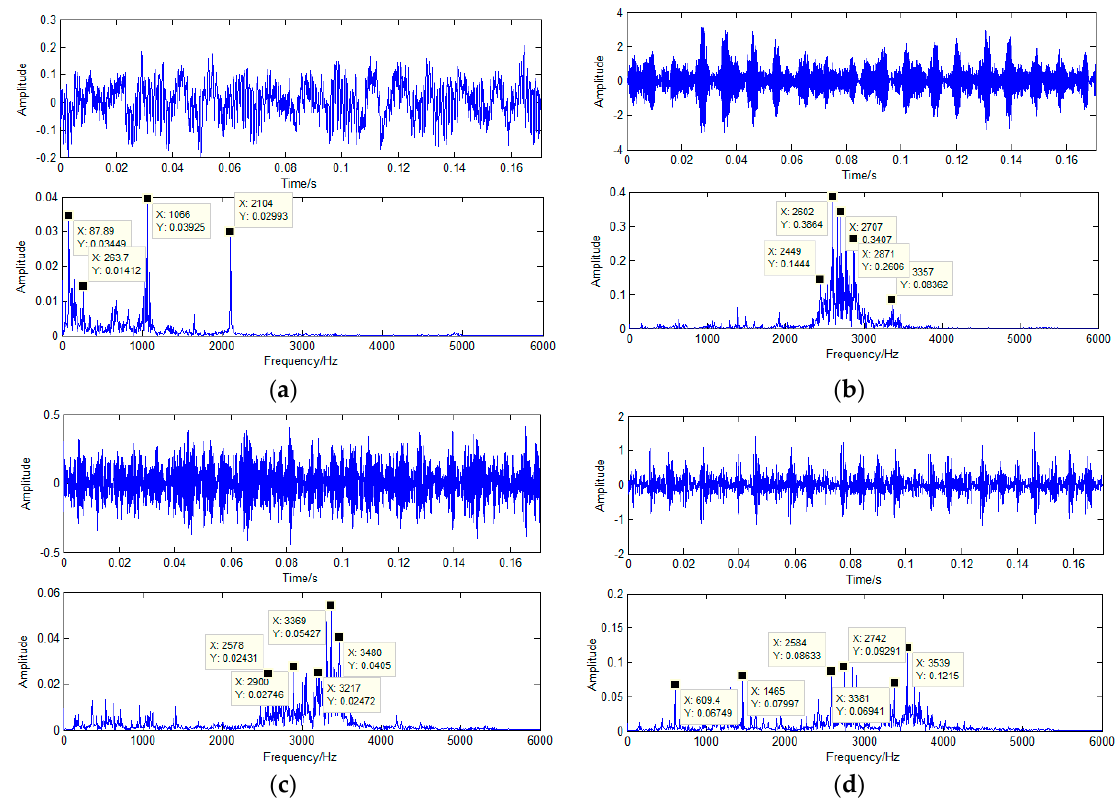
Figure 7. Time domain waveform and spectrogram of the four health conditions. ( a ) Normal condition (N); ( b ) Outer race fault (ORF); ( c ) Ball fault (BF); ( d ) Inter race fault (IRF).